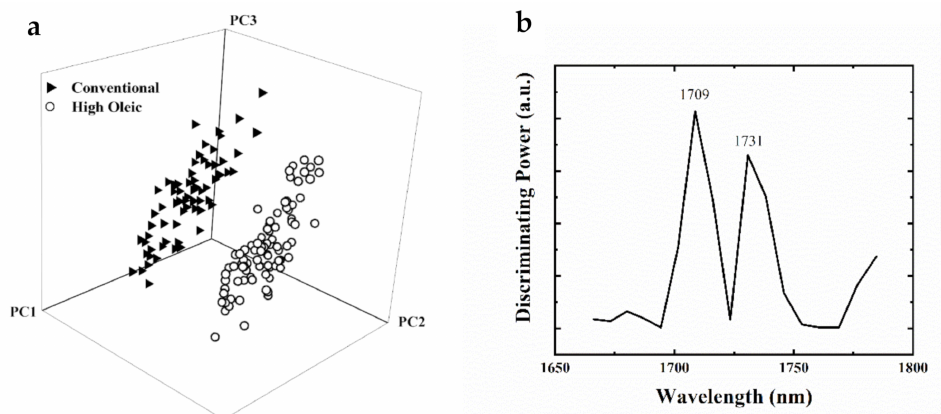
Figure 3. Soft independent modeling of class analogy (SIMCA) 3D projection plot for high-oleic and conventional soybean varieties ( a ) SIMCA discriminating plot based on the NIR spectra of high-oleic and conventional soybean samples using the handheld NIR sensor, showing bands and regions responsible for class separation ( b ).